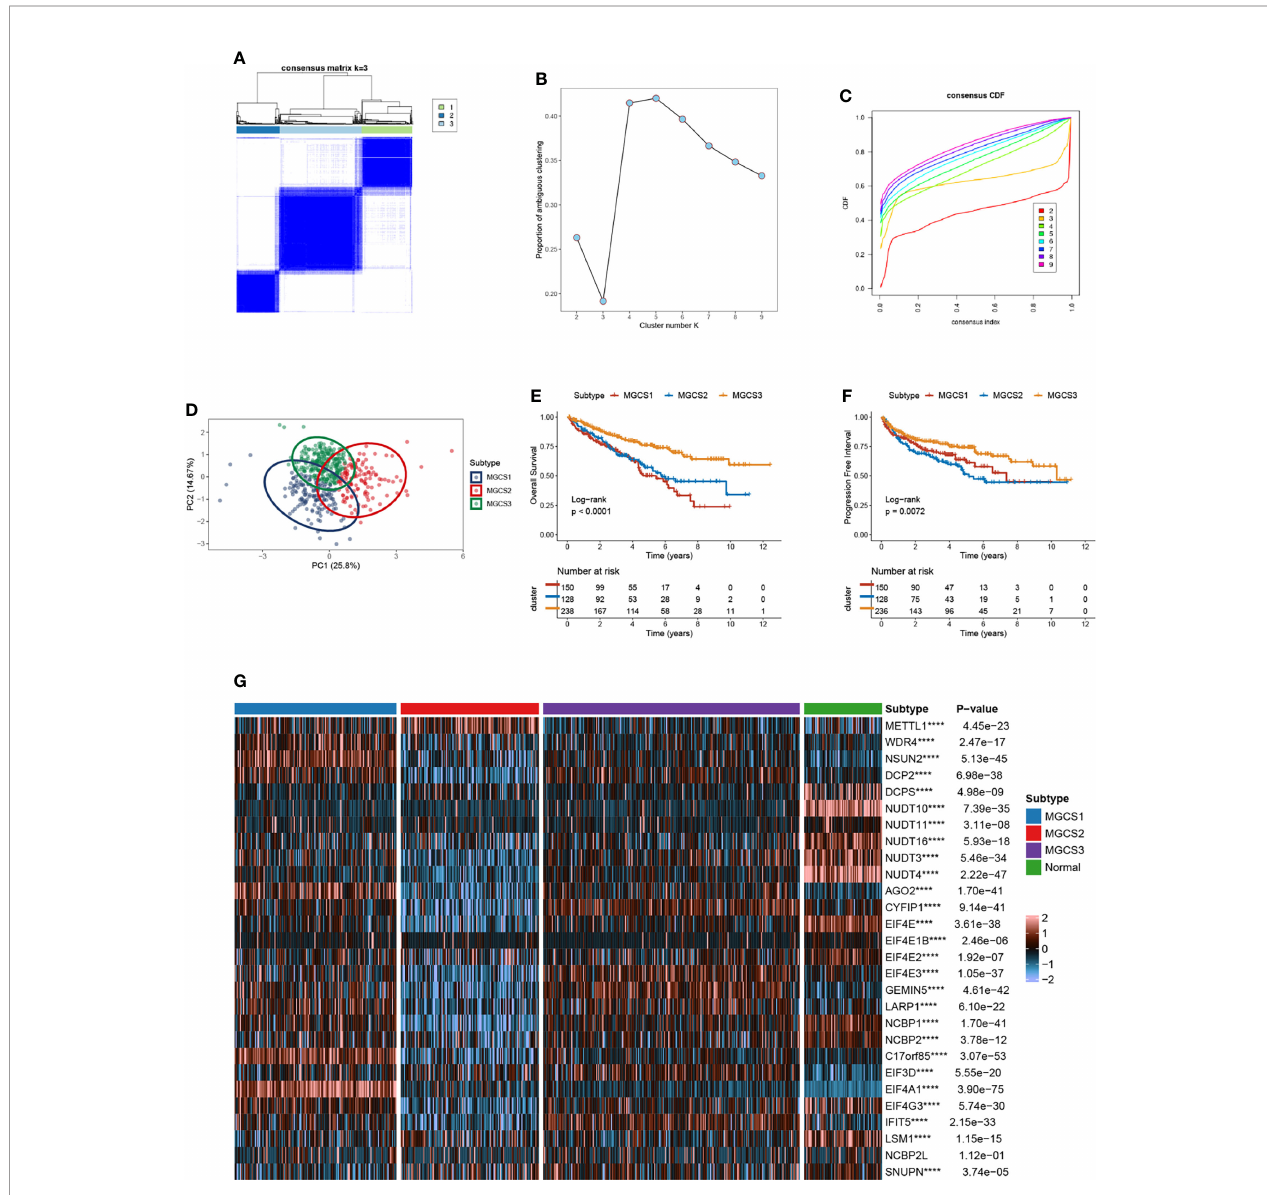
FIGURE 2 | Identi fi cation of m 7 G subtypes of ccRCC. (A) Consensus matrix of samples in TCGA-ccRCC for k=3. (B) The number of optimum clusters is determined by the lowest proportion of ambiguous clustering. (C) The cumulative distribution function curves for k = 2 to 9. (D) The principal component plot is based on m 7 G -related genes. (E, F) Kaplan-Meier survival analysis for overall survival (left) and progression-free interval (right) of the three subtypes in TCGA-ccRCC dataset. (G) The expression pro fi les of the m 7 G regulators in three subtypes and normal kidney samples. ****P <